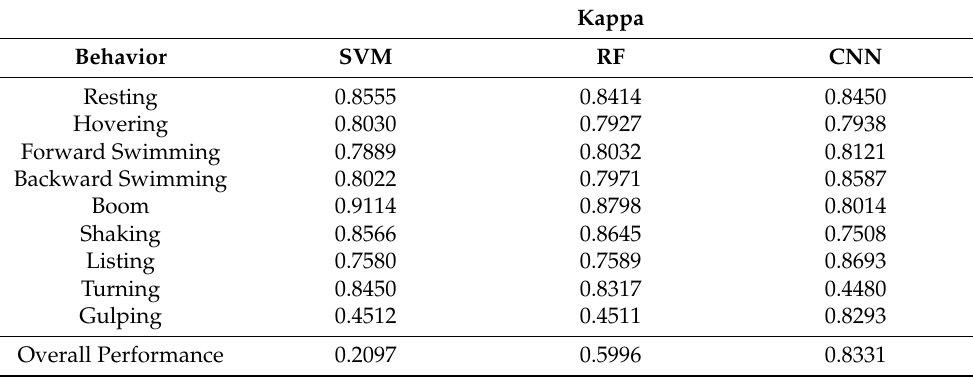
Table 4. Kappa results for the conventional machine learning approaches: support vector machine (SVM) and random forest (RF), and the deep learning approach: convolutional neural network (CNN). Overall Performance for Kappa was calculated using Equations (13)–(15).